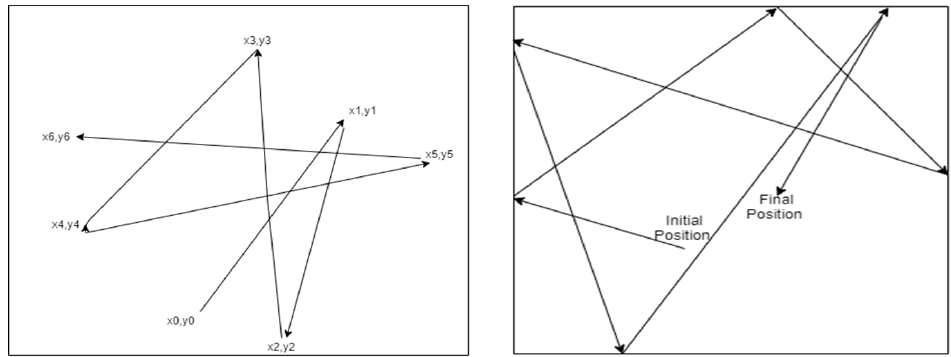
Figure 2. Movement of Mobile Nodes in RWM ( Left ) and RDM ( Right ).